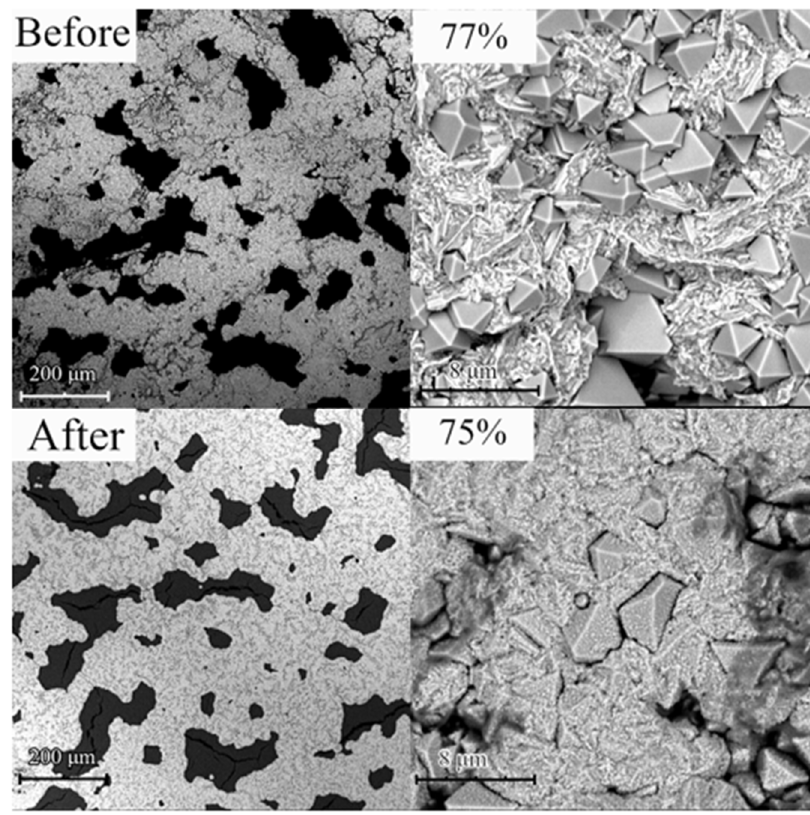
Figure 3. SEM pictures of electrodeposited copper catalyst layer with 0.3 mA/cm 2 short pulse (7 ms) current before and after 60 min electrolysis (in the pictures at the top and bottom, left and right is the same layer in two different magnifications, respectively scales 200 and 8 µm).